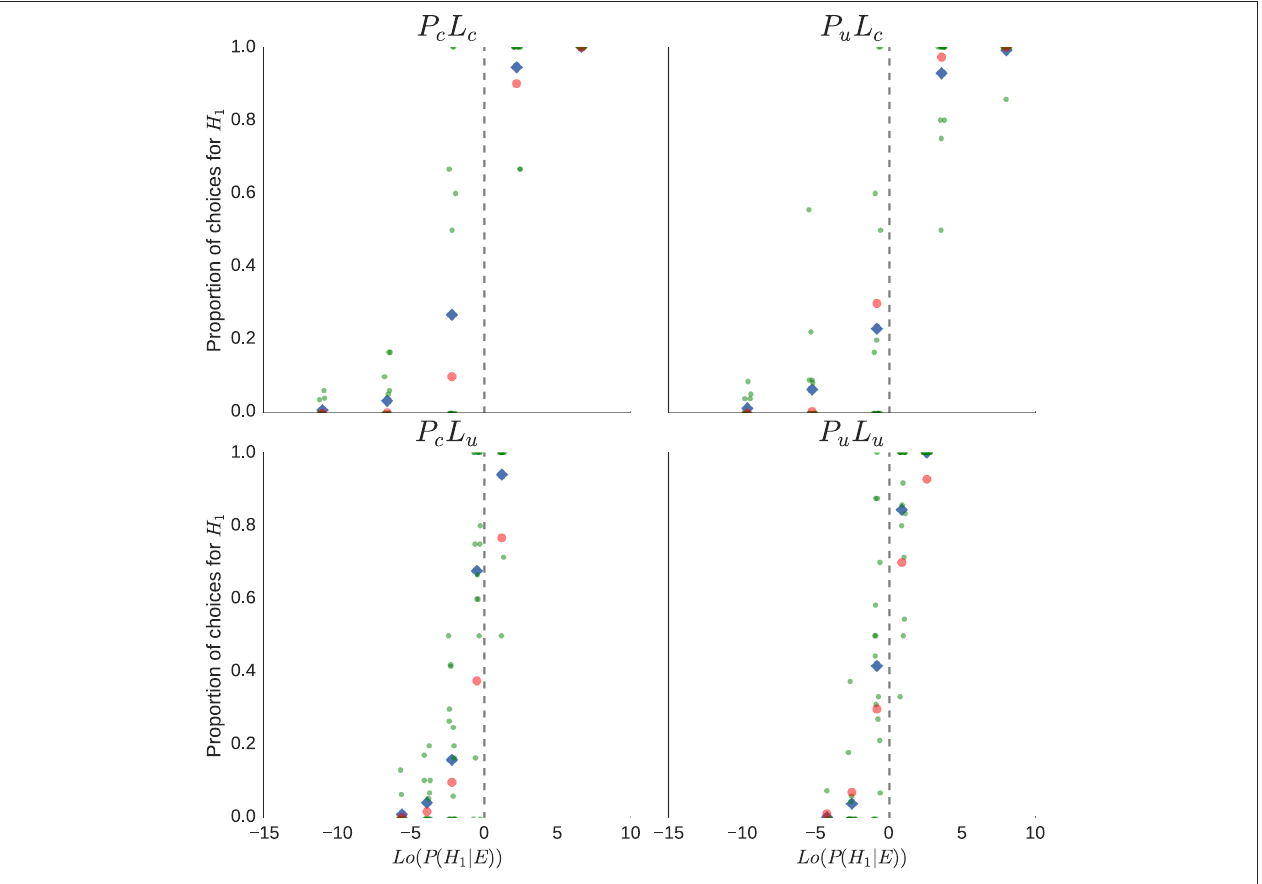
FIGURE 7 | Explorative data analysis for the individual proportions of H 1 -inferences per participant and sequence of drawn balls. Each point represents the proportion of an individual per sequence, diamond shapes indicate the mean proportion of H 1 -inferences per sequence, and red dots indicate the appropriate proportion of H 1 -inferences, given the posterior probability P ( H 1 | E ). Overlapping proportions are “jittered” by adding small random noise on the